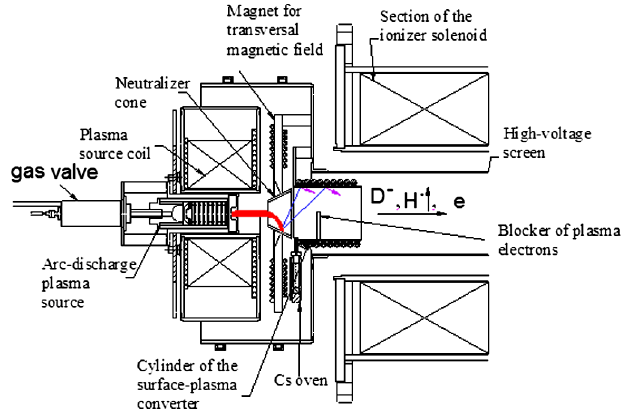
FIG. 14. Generation of a cold D (cid:1) plasma jet for resonant charge-exchange negative ionization of polarized hydrogen atoms (INR version)